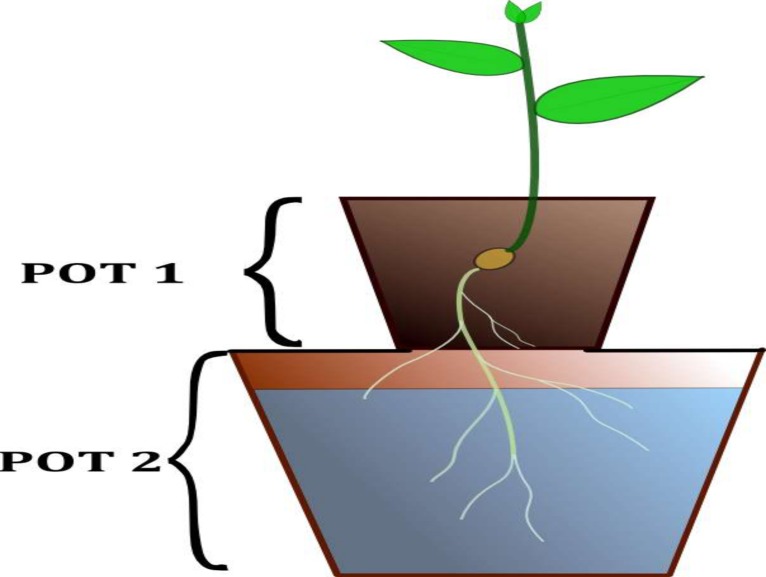
Illustration of the set up of the double pot experiment.